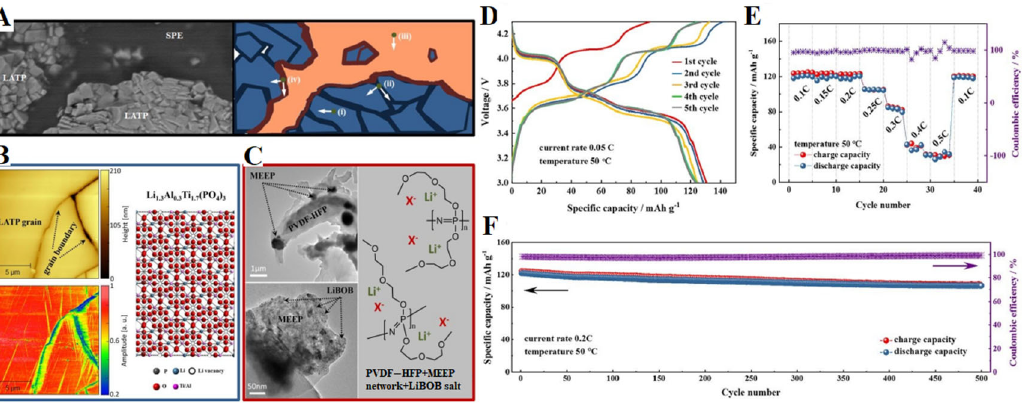
Figure 13. ( A ) SEM image. ( B ) amplitude signal of AFM topography along with electrochemical strain microscopy. ( C ) TEM images; ( D ) charge–discharge curve of the initial five cycles at a current rate of 0.05°C, ( E ) rate capability at current rates from 0.1°C to 0.5°C, respectively, and ( F ) long–term cycling measurement at a current rate of 0.2°C. [81]